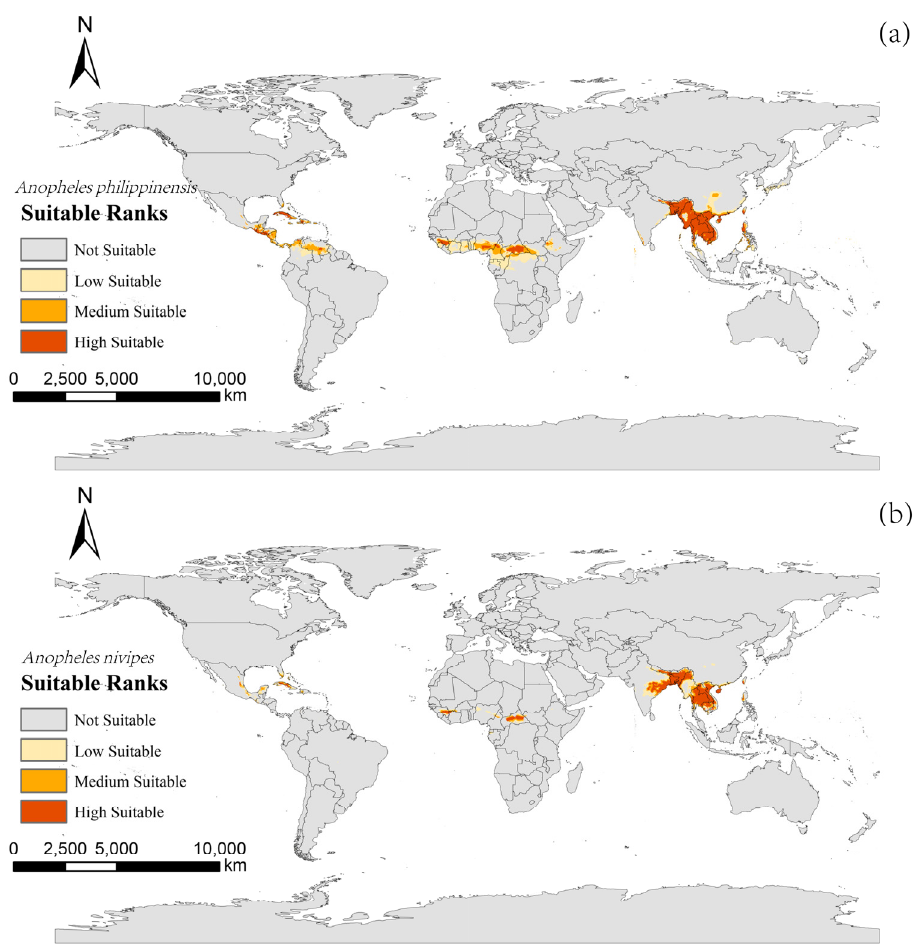
Figure 2. Potentially suitable areas for Anopheles philippinensis ( a ) and Anopheles nivipes ( b ) at the current time using the MaxEnt model.